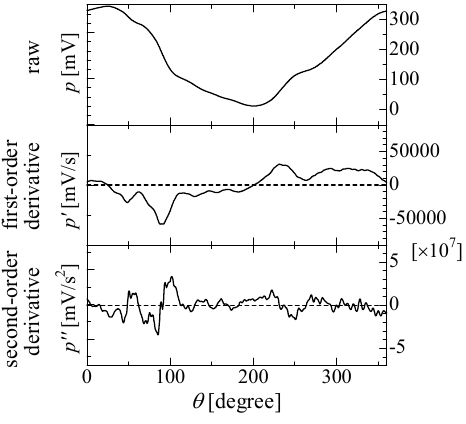
Fig. 10 Phase-averaged signals (FOOT